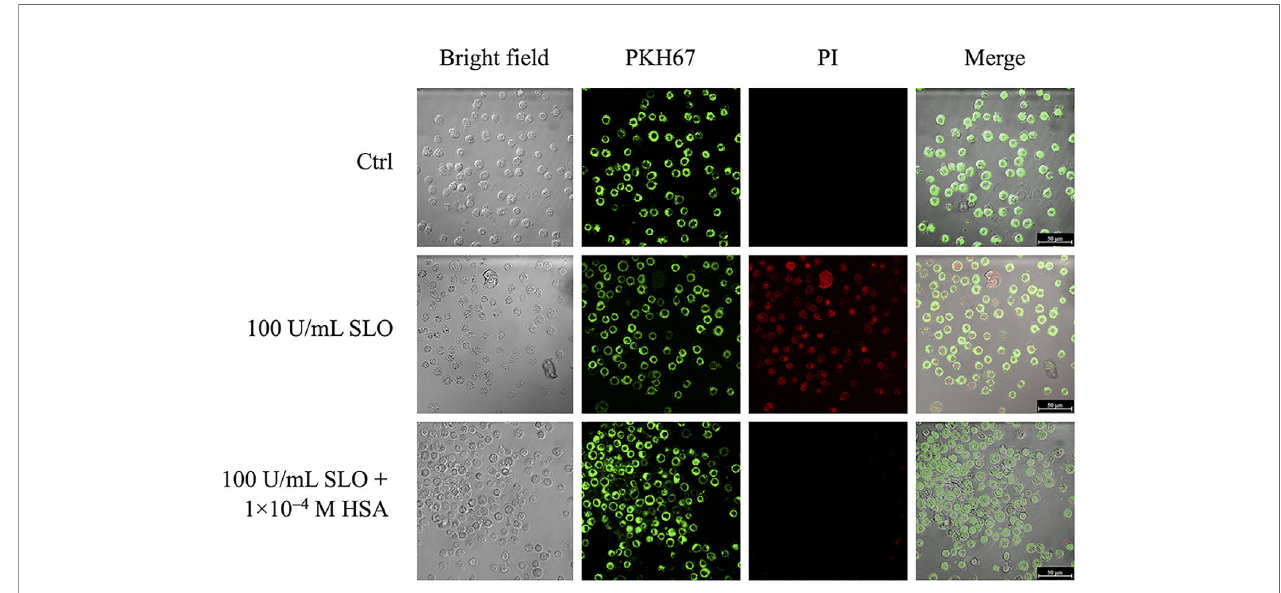
FIGURE 3 | HSA inhibits SLO-induced cells membrane permeabilization. HEp-2 cells were stained with the PKH67 fl uorescent cell linker dye solution (green signal), in order to visualize cells membrane. After 24 h, stained cells were treated with 100 U/mL of activated SLO, in the absence or presence of 1.0×10 − 4 M HSA. Propidium iodide (PI) staining, which is not permeant to live cells, allowed to detect dead cells. Cells were immediately analyzed and acquired using the LCS Leica confocal microscope (Leica Microsystems, Heidelberg, Germany).